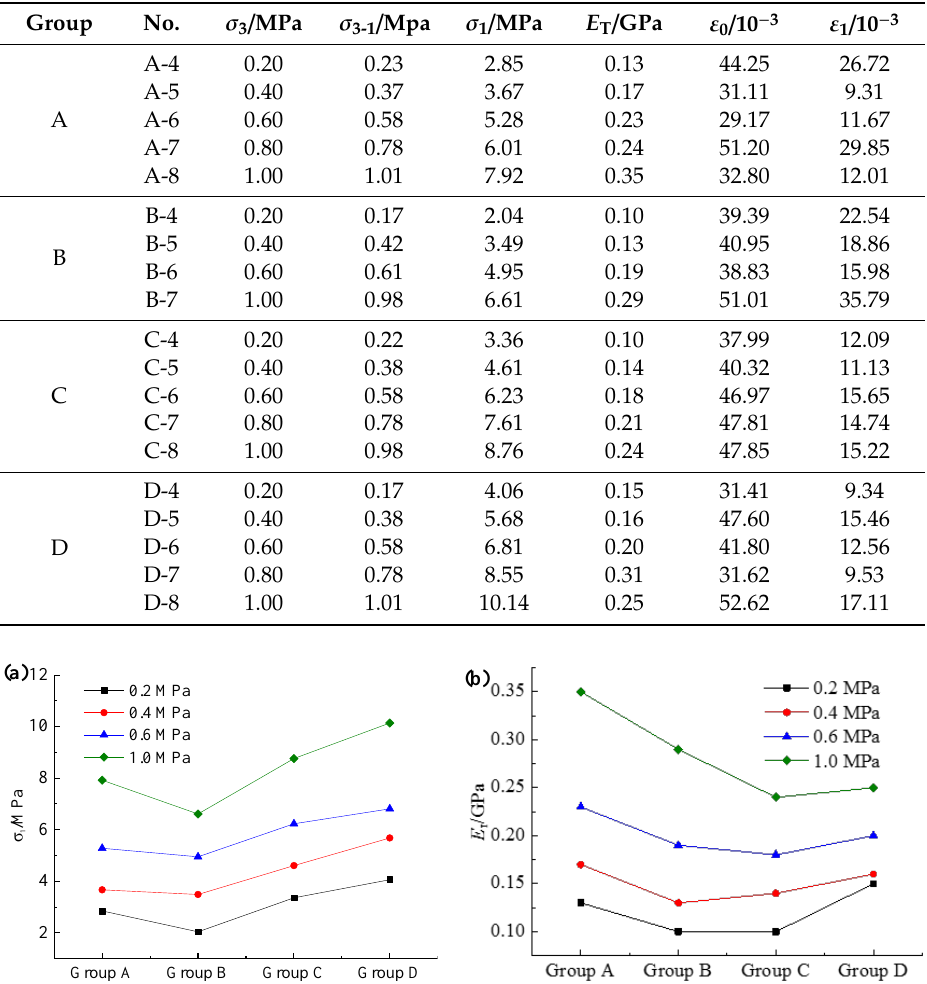
Table 4. Triaxial test results of briquettes with different particle sizes.